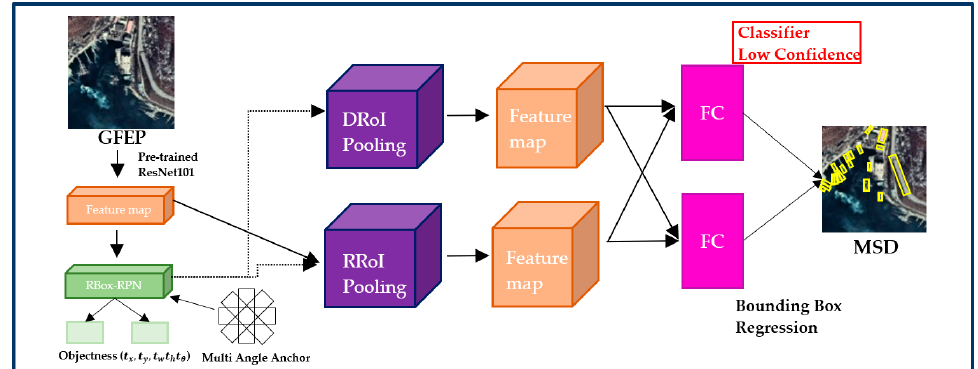
Figure 3. Architecture of MSD for a large number of detection candidates.